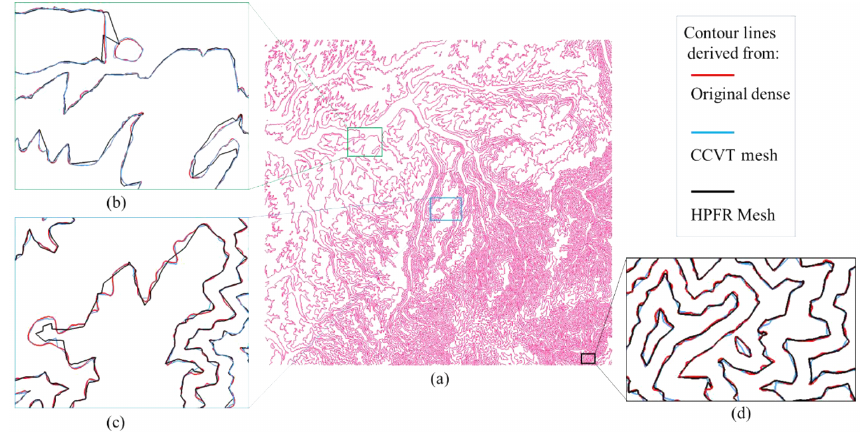
Figure 16. Comparison of the derived contour lines. The contours from the dense UTM11 dataset are shown in (a) and rendered in red. Three areas in the boxes were magnified to show the differences in the contour configurations. The blue contour lines are from the cCVT- generalised TIN surface, and the black lines are from the HFPR-generated TIN surface. According to the illustrations in (a) and (b) , the contours that were derived from the cCVT grid (rendered in blue) are more in line with those from the original dense surface (rendered in red). The contours from the HFPR grid (rendered in black) may sometimes edge out on areas with steep slopes, as shown in (d) , because the HFPR method accumulated a relatively abundant of sample points around these